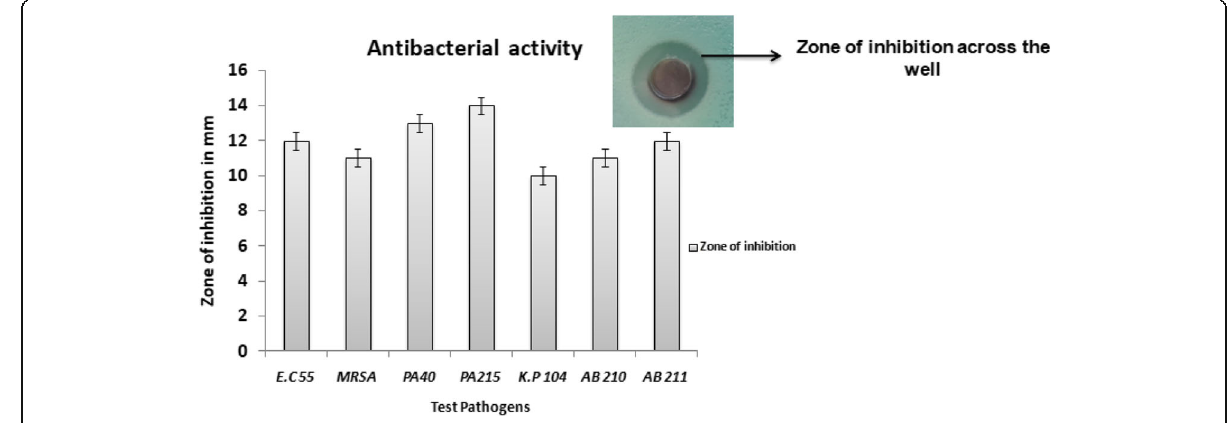
Fig. 5 Antibacterial activity of nano hybrid particles (Ag-CuO)